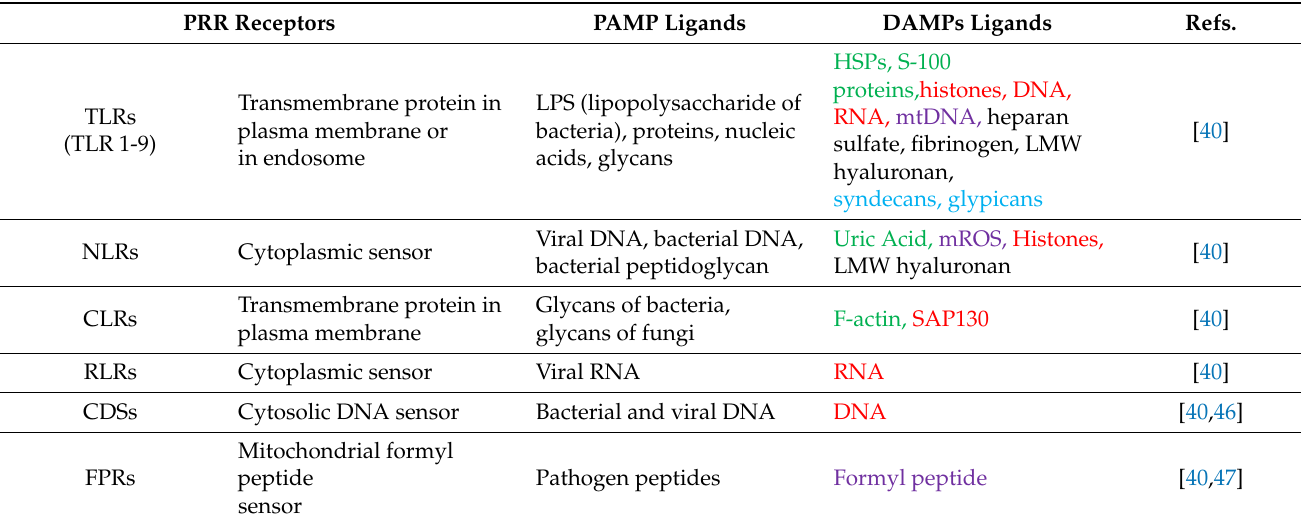
Table 4. Schematic table showing the localization of PPRs, recognized targets, and the inflammatory pathways activated by them.